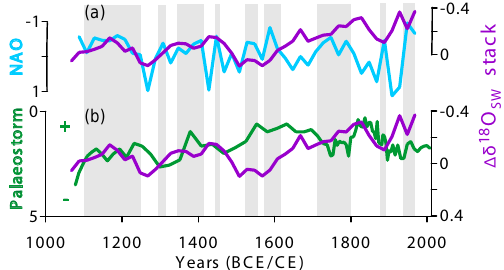
Figure 9. Mg / Ca–SST and alkenone–SST Minorca anomaly stacks during the last centuries plotted with AMO reconstruction (Gray et al.,